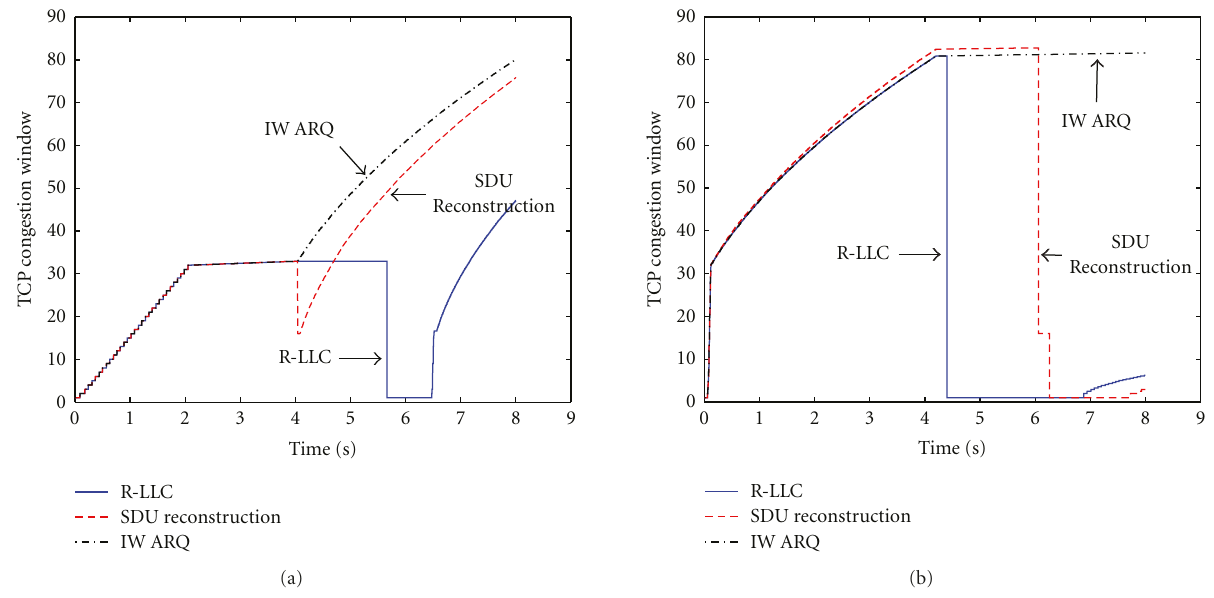
Figure 6: TCP congestion window comparison (UMTS data rate 64kb/s): (a) UMTS → WiMAX; (b) WiMAX → UMTS.